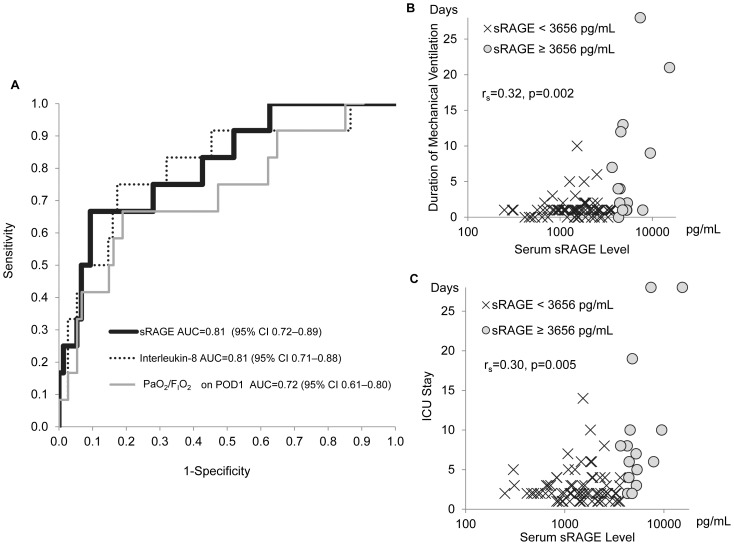
Predictive performance of the post-operative levels of the soluble isoform of the receptor for advanced glycation end products (sRAGE) for postoperative respiratory failure and prolongation of stay in the intensive care unit (ICU).(A) Receiver operating characteristic (ROC) curve analysis for predicting performance of Post-Op levels of biomarkers (sRAGE and interleukin-8) and PaO2/FIO2 on POD 1. ROC curves for sRAGE, interleukin-8, and PaO2/FIO2 are shown with their area under the curve (AUC) calculations; (B) Relationship between serum levels of sRAGE and duration of mechanical ventilation; (C) Relationship between the serum levels of sRAGE and the length of stay in the ICU. In graph B and C, patients were dichotomized using the cut-off value of 3656 pg/mL, which was calculated from the ROC curve analysis shown in graph A. Patients with a high level of sRAGE (≥3656 pg/mL) showed a significantly longer duration of mechanical ventilation (p = 0.0001) and a longer stay in the ICU (p<0.0001) than those with low sRAGE (<3656 pg/mL) (Mann-Whitney U-test). Spearman’s correlation coefficients (rs) are shown with p values.